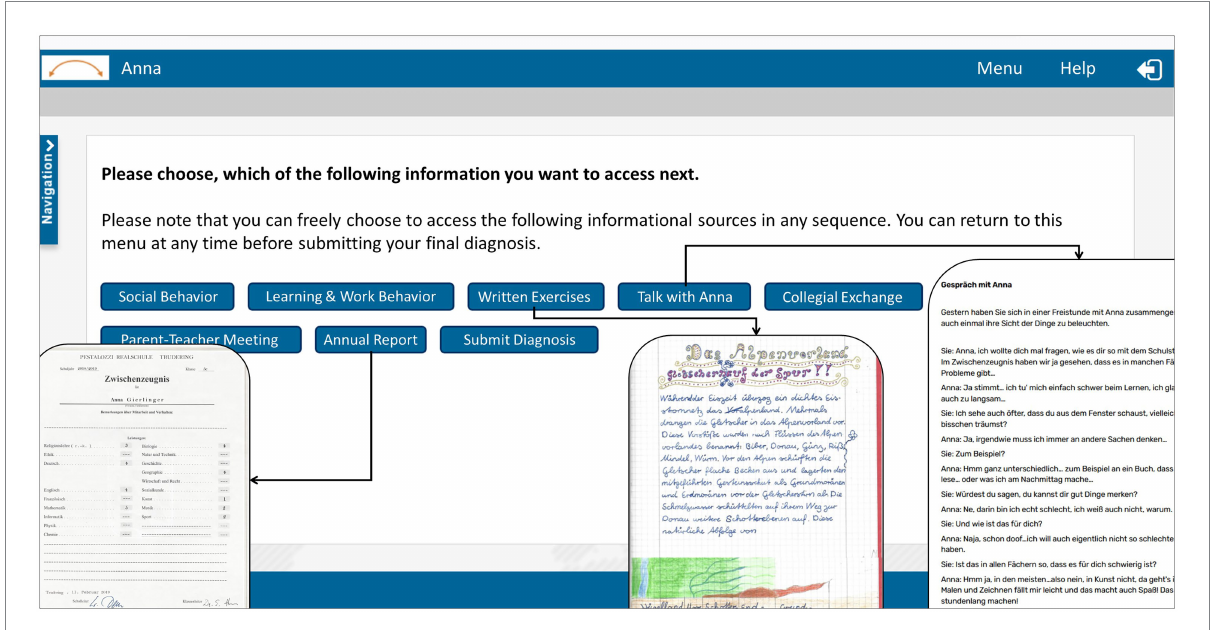
FIGURE 2 Example of the case materials in the simulation-based learning